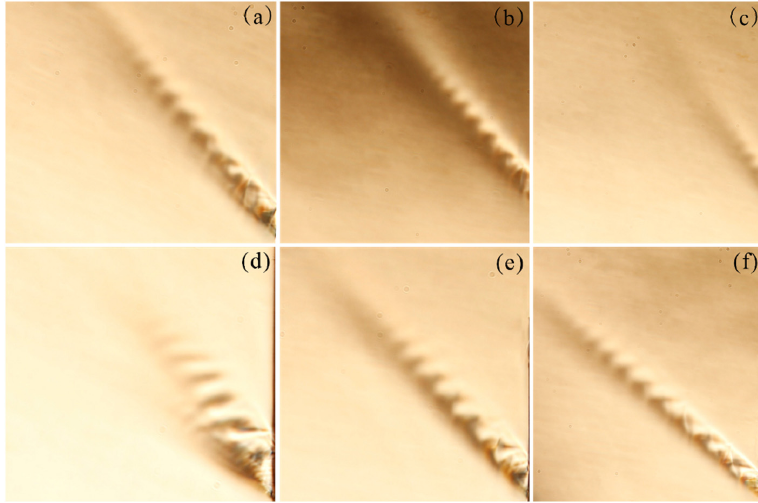
Figure 12. Schlieren photographs of the shock structures at nozzle outlet: ( a ) L s = 13 mm; ( b ) L s = 25 mm; ( c ) L s = 37 mm; ( d ) θ = 24°; ( e ) θ = 36°; and ( f ) θ = 48°.